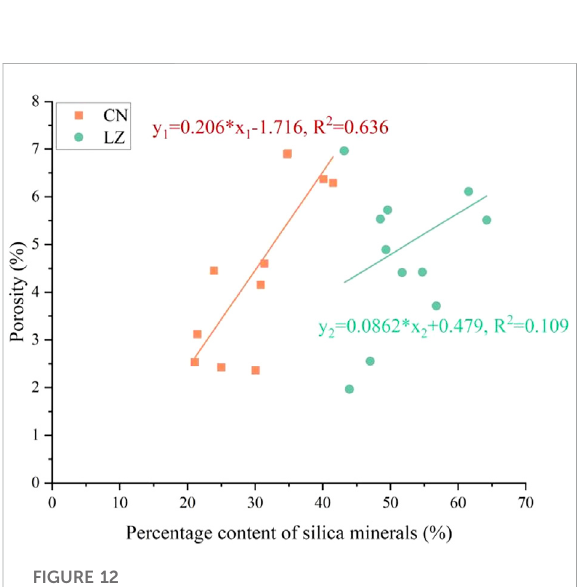
FIGURE 12 Relationship between siliceous mineral content and porosity in the Longmaxi Formation shale in the study